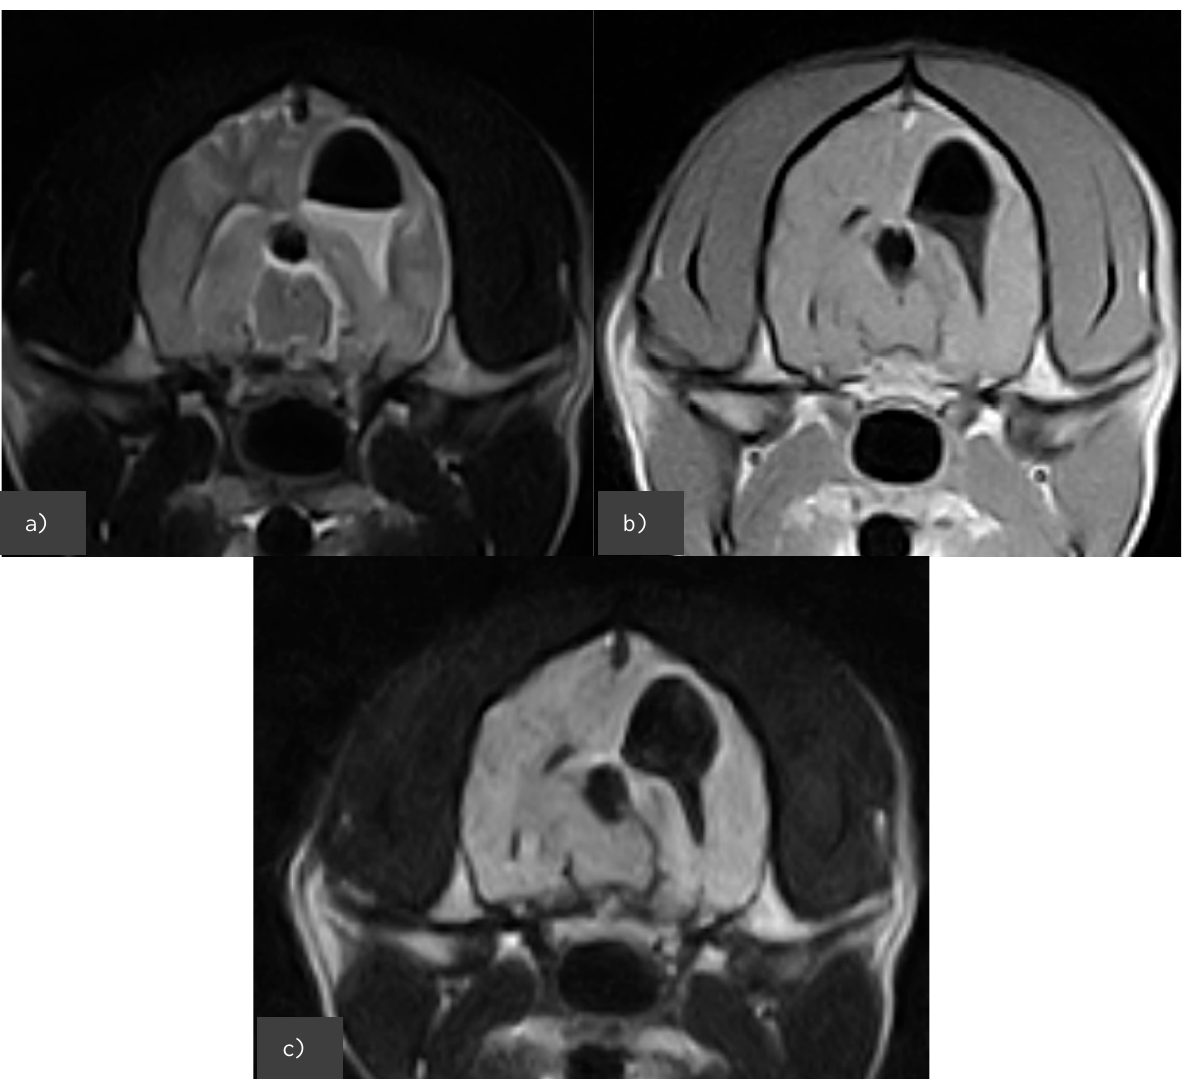
Fig. 5. Magnetic resonance imaging of the dog with post-traumatic changes in the brain (14 days after injury) Note : a – axial section at the level of the lateral and third ventricles in the T2 mode; b – axial section at the level of the lateral and third ven- tricles in the T1 mode with contrast enhancement; c – axial section at the level of the lateral and third ventricles in the FLAIR mode